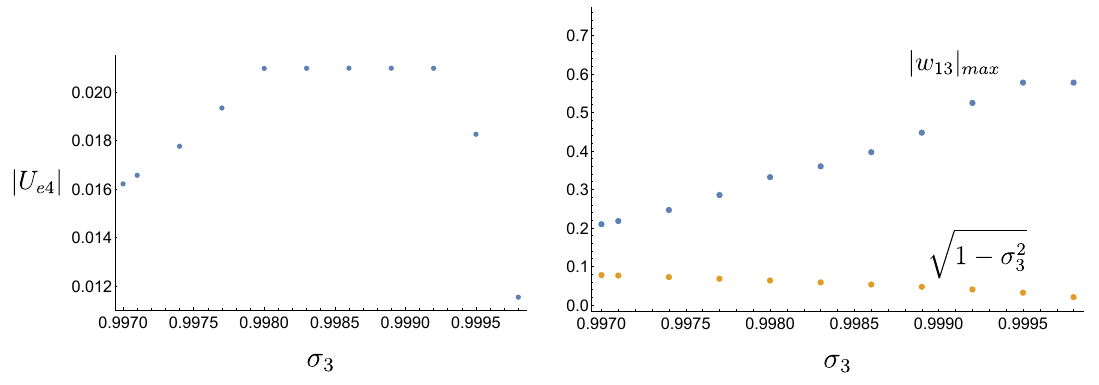
Figure 2 . Upper bounds for j U e 4 j as a function of (cid:27) 3 in the massive case (I) (left). j U e 4 j approaches the maximum for middle values of (cid:27) 3 . On right, the behavior of particular constituents of j U e 4 j , de(cid:12)ned in (4.13), as a function of (cid:27) 3 is